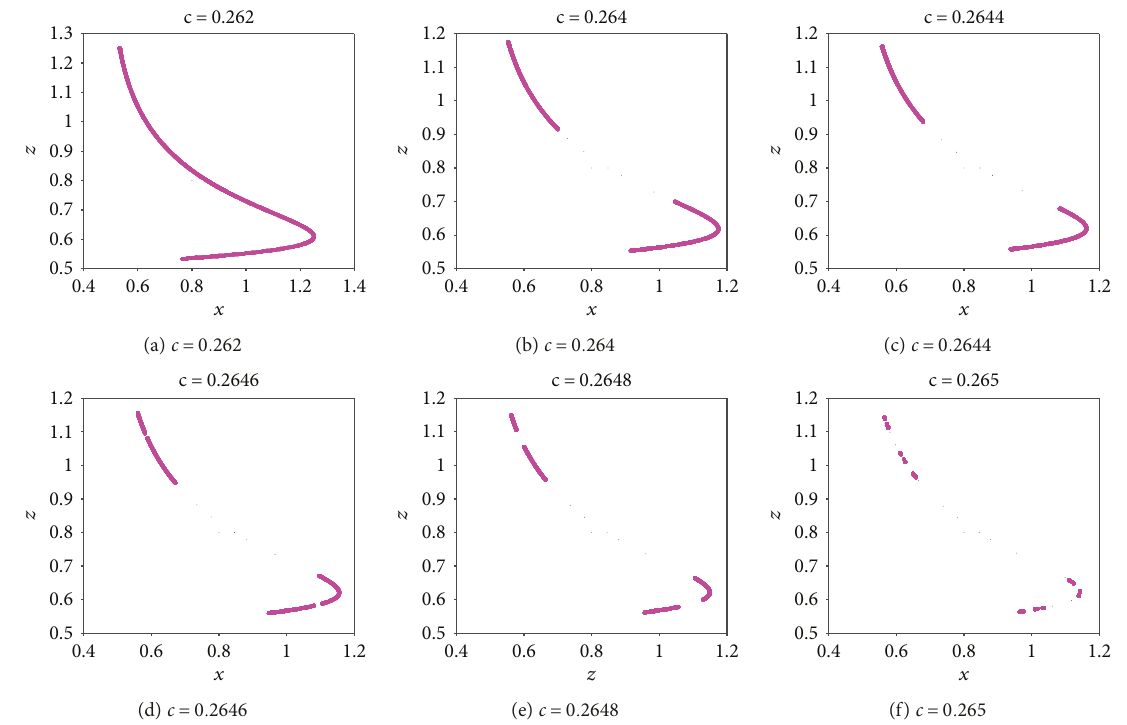
Figure 4: Bifurcation diagrams of family OM10 on p x for free independent critical points. Table 1: Nonlinear test functions along with their zeros. Nonlinear function